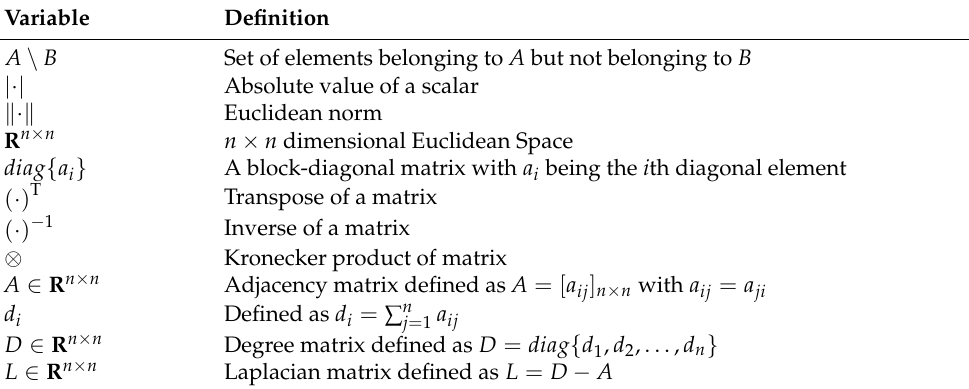
Table 1. Notations and variables used in this